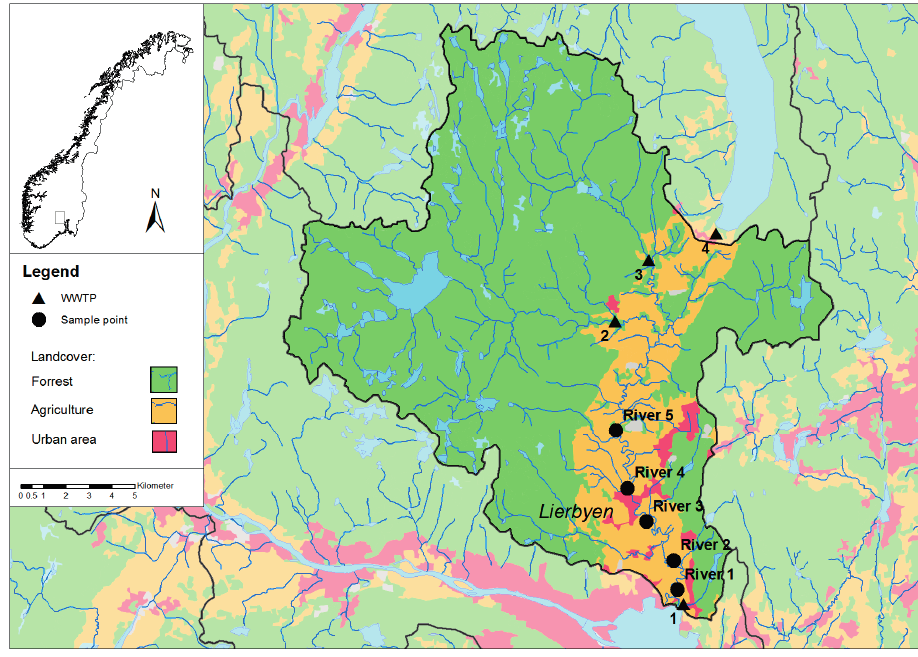
Figure 1. Study area: The Lier River catchment area with different land cover types, the four municipal WWTPs and the municipal river sampling